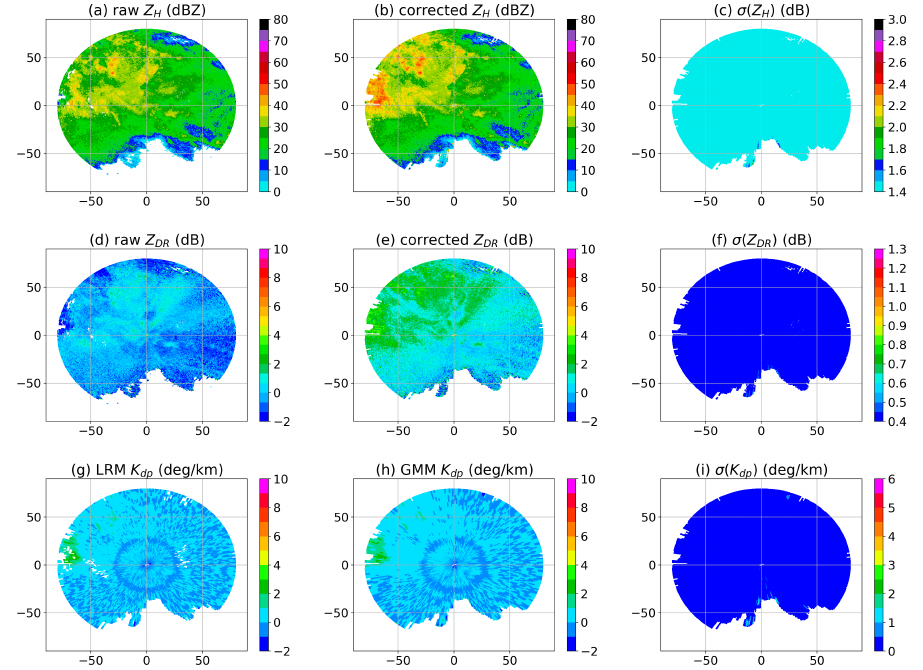
Figure 6. Same as Figure 3, but the data were collected at 0339 UTC on 3 July